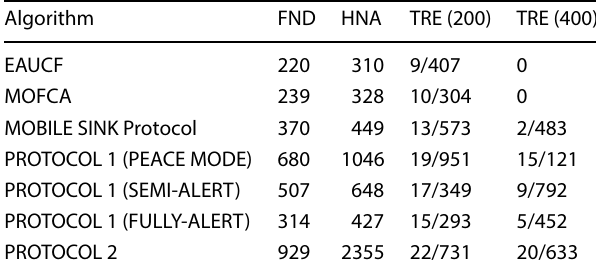
Table 4 Simulation results in scenario